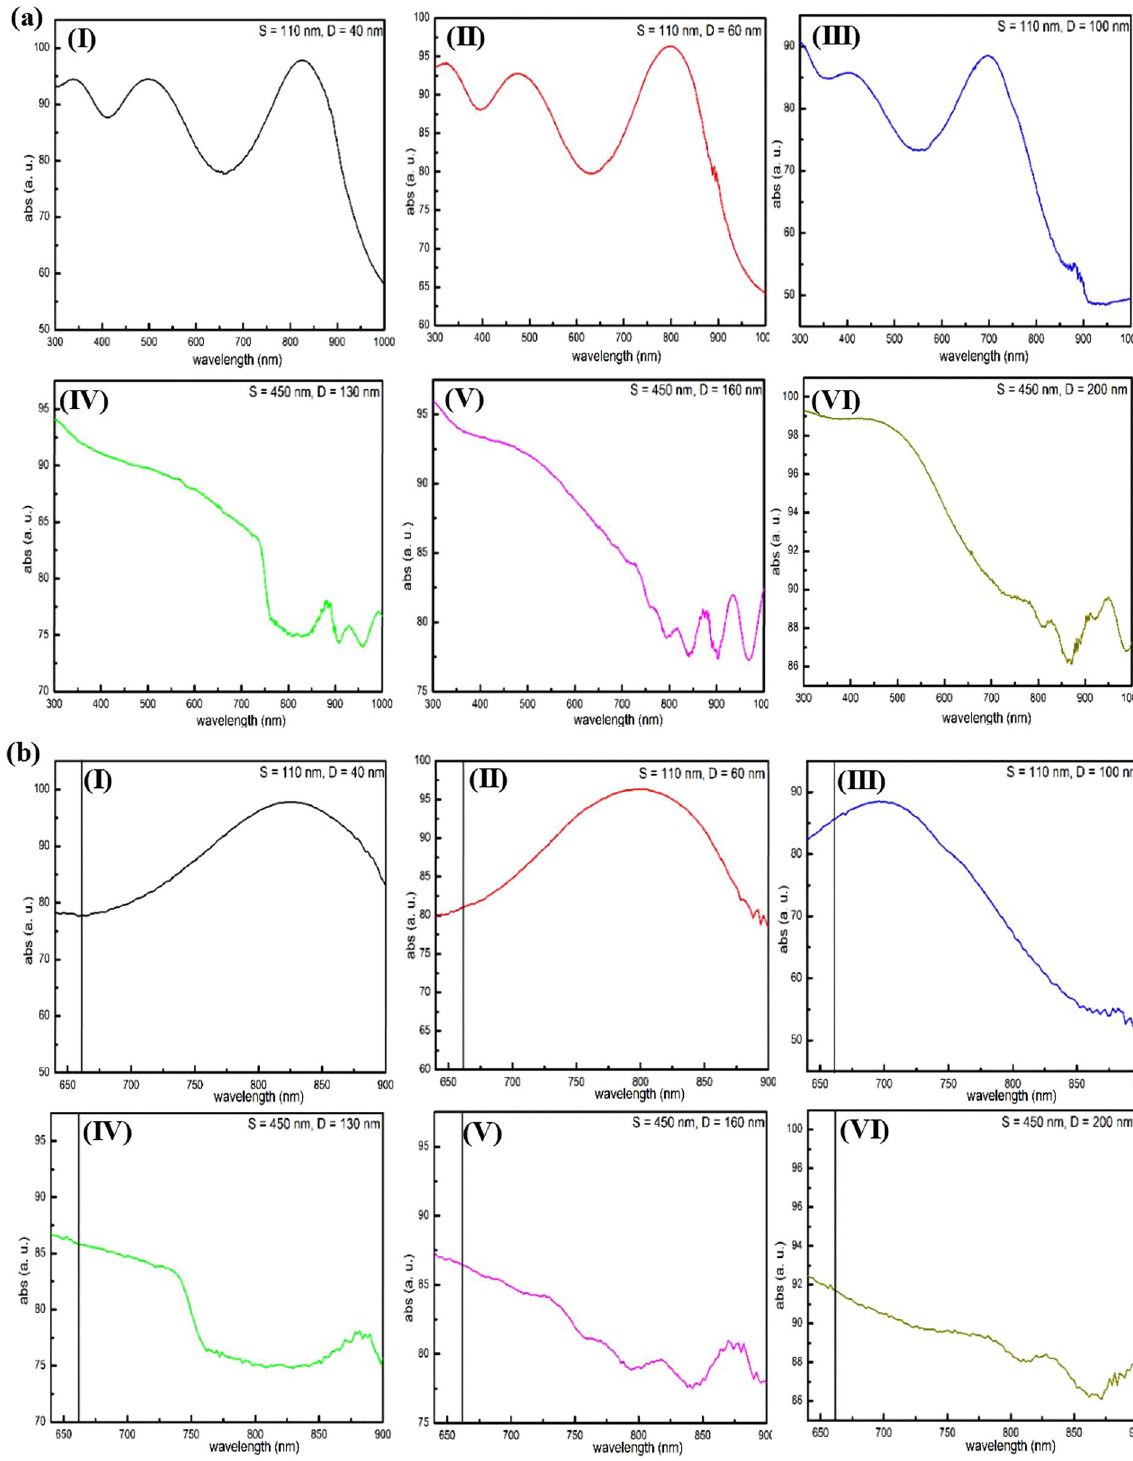
Figure 4. Absorbance intensity of hybrid multi-layered nanoporous arrayed films deposited on six AAO templates with different geometries. (I) S = 110 nm, D = 40 nm; (II) S = 110 nm, D = 60 nm; (III) S = 110 nm, D = 100 nm; (IV) S = 450 nm, D = 130 nm; (V) S = 450 nm, D = 160 nm and (VI) S = 450 nm, D = 200 nm. ( a ) Full range spectra. ( b ) Magnified local spectra with the vertical black line marks excitation at 660